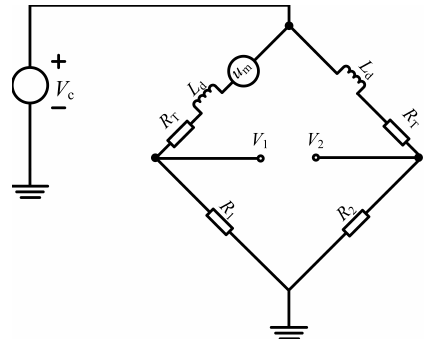
Figure 3. Principle diagram of the Wheatstone bridge circuit.